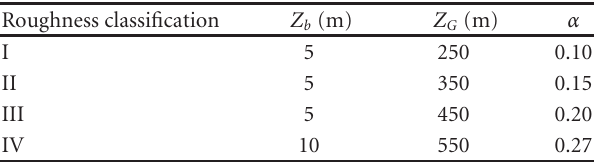
Table 1: Coe ffi cients for the vertical profiles of the mean horizontal wind speed which appear in Figure 2 (height correction coe ffi cients for the mean horizontal wind speed E pv .)